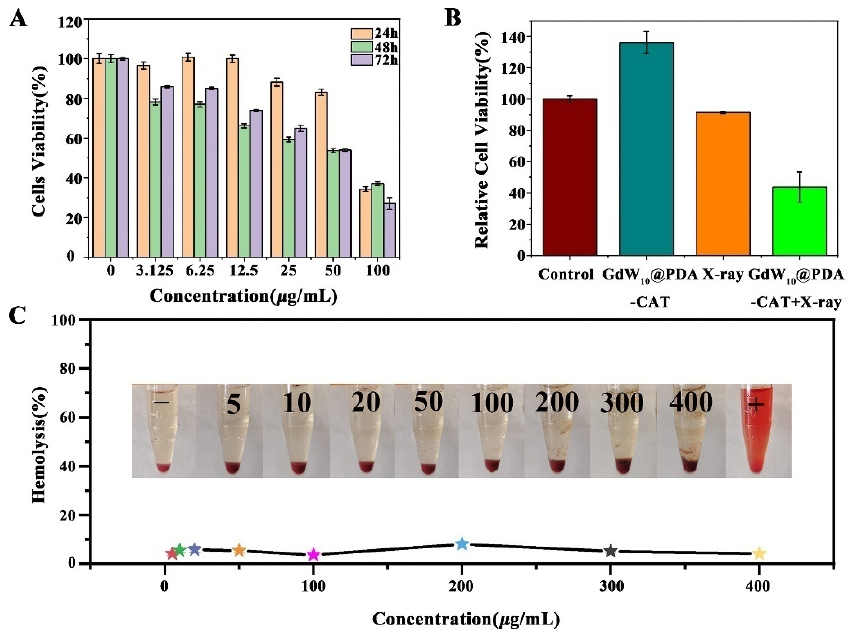
Figure 2 . In vitro cytotoxicity evaluation of GdW 10 @PDA-CAT. ( A ) Cell viability of HT29 cells treated with GdW 10 @PDA-CAT of different concentrations for different times. ( B ) Vitality of HT29 cells after different treatments (GdW 10 @PDA-CAT: 50 μ g/mL, X-ray: 6 Gy) for 24 h. ( C ) In vitro hemolysis rate of red blood cells incubated with different concentrations of GdW 10 @PDA-CAT. Deionized water (+) and PBS ( − ) acted as positive and negative controls, respectively.